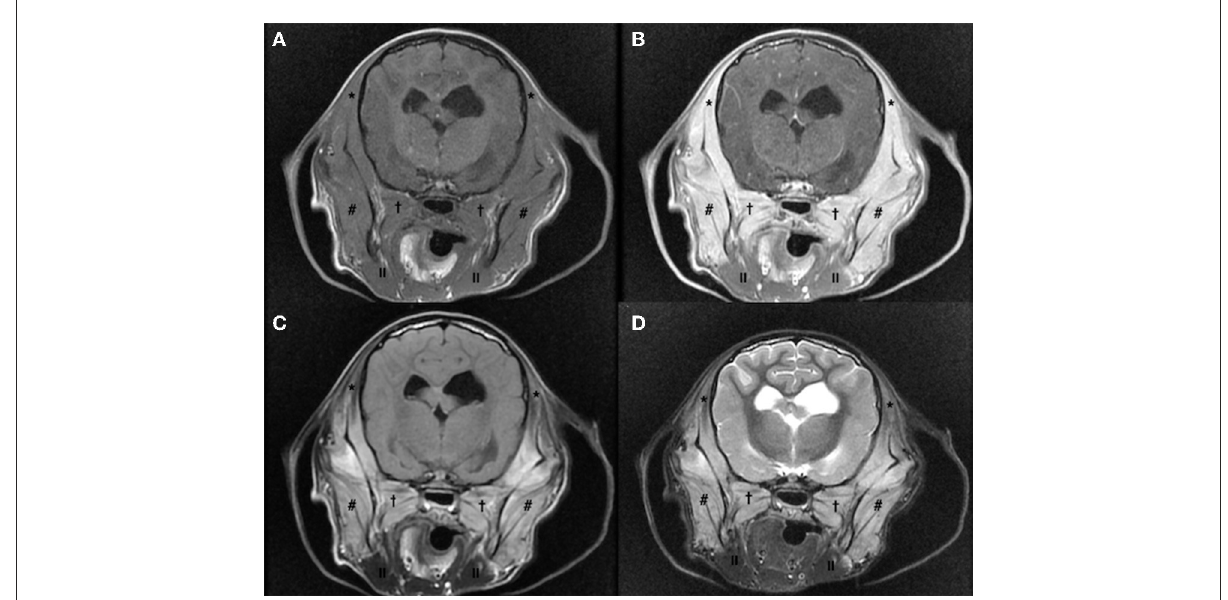
FIGURE2 Magnetic resonance imaging study of the head of a 5-month old Cavalier King Charles Spaniel affected by masticatory muscle myositis; pre-contrast T1-W image (A) , post-contrast T1-W image (B) , fluid attenuated inversion recovery (FLAIR) (C) and short tau inversion recovery (STIR) (D) images. Note the severe, diffuse, and bilateral atrophy of temporalis, masseter, and pterygoid muscles that appear isointense on T1-W images pre-contrast (A) and showing a strong contrast enhancement (B) ; these muscles appear hyperintense on FLAIR (C) and STIR (D) images, compared to the signal in normal muscles (* temporalis muscle, # masseter muscle, † pterygoid muscle, || digastricus muscle).